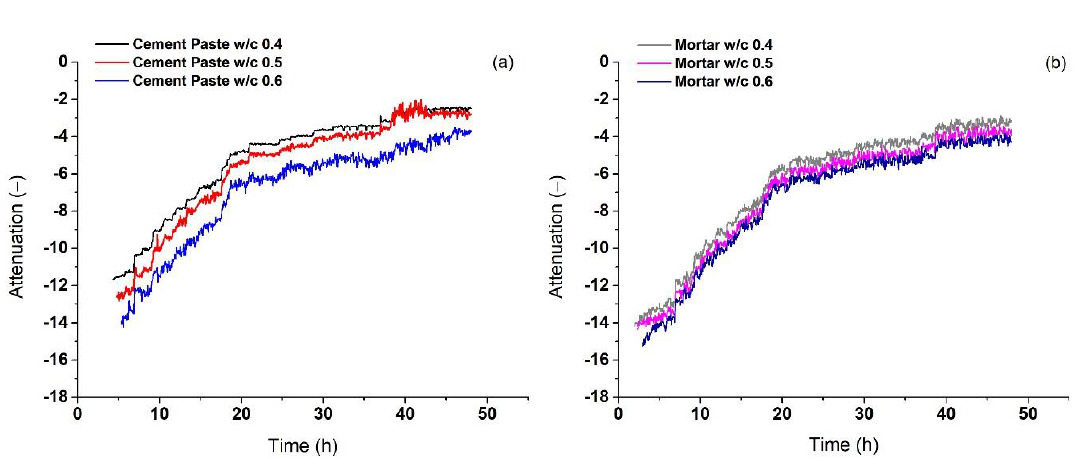
Figure 11. Monitoring the attenuation during hardening for different w/c ratios ( a ) cement paste and ( b ) mortar.